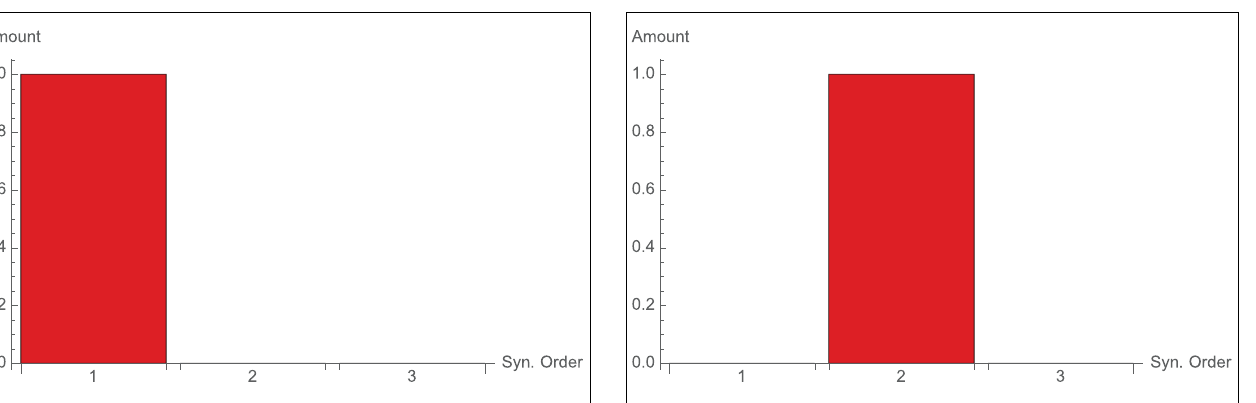
FIGURE 5 | Synergies of different orders for correlated inputs, Example 3.3 .